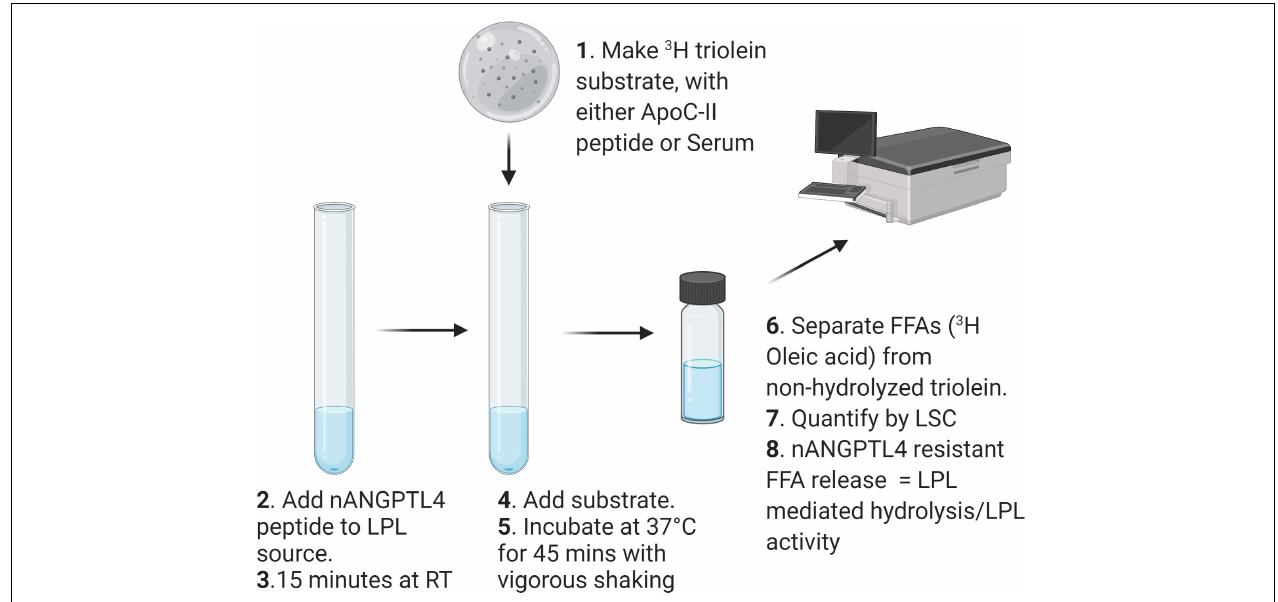
FIGURE 1 | Schematic workflow for measuring LPL activity with a triolein